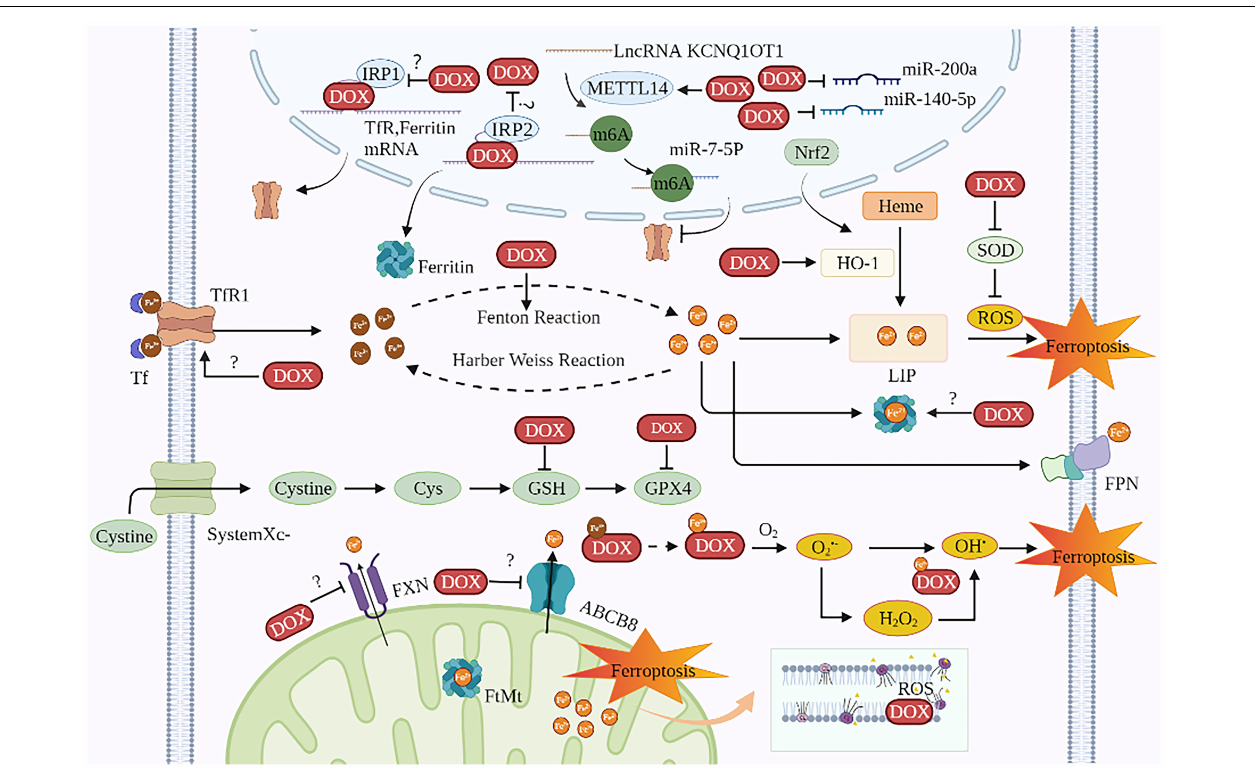
FIGURE 2 | The mechanisms of DIC based on ferroptosis. DOX induces ferroptosis in cardiomyocytes involves two major mechanisms: one is to disrupt iron homeostasis and the other is to promote lipid peroxidation. The targets of DOX on iron disorder are Tf, ferritin, HO-1, FXN, ABCB8, IRE, IRP, and KCNQ1OT1m6A. The targets of DOX for lipid peroxidation are ROS, SOD, GPX4, and GSH. The site of iron death in cardiomyocytes is probably the mitochondria. TfR1, transferrin receptor 1; Tf, transferrin; DOX, doxorubicin; IRP, iron regulatory protein; METTL14, methyltransferase-like 14; Nrf2, nuclear factor (erythroid-derived 2)-like 2; LIP, labile iron pool; HO-1, heme oxygenase 1; ROS, reactive oxygen species; SOD, superoxide dismutase; Cys, cysteine; GSH, glutathione; GPX4, glutathione peroxidase 4; FPN, ferroportin; FXN, frataxin; ABCB8, ABC protein-B8; O 2 , oxygen; O 2 •− , active oxygen; FtMt, mitochondrial ferritin; CL, cardiolipin; OH • , hydroxyl